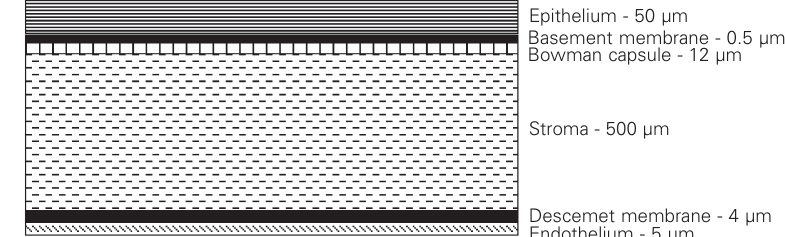
Figure 1. Schematic representation of human corneal layers. Stroma comprises about 90% of the corneal depth and is covered anteriorly with an epithelial layer and posteriorly with endothelium. Both layers are separated from the stroma by basement membranes. Only epithelial, stromal and endothelial layers are cellular.